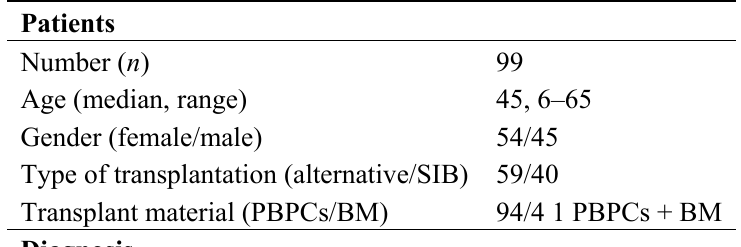
Table 1. Patient and donor